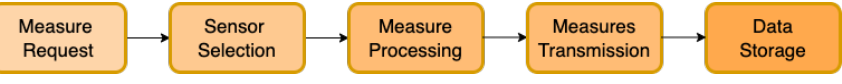
Figure 1. System operation